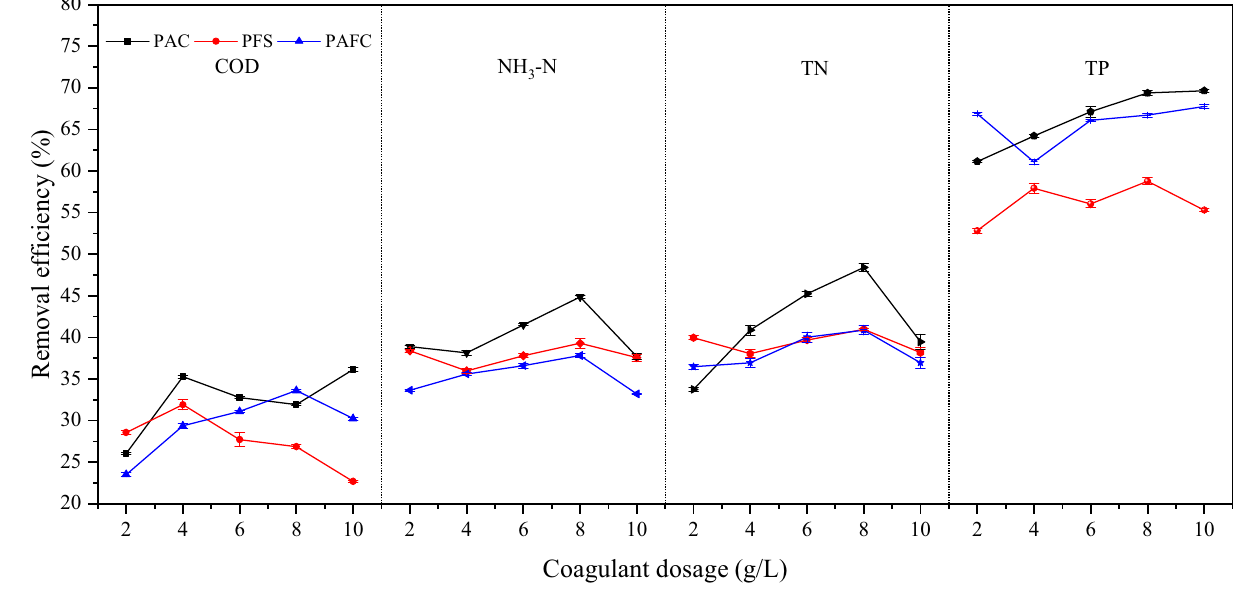
Figure 1. Removal efficiency of pollutants from fruit and vegetable wastewater by different